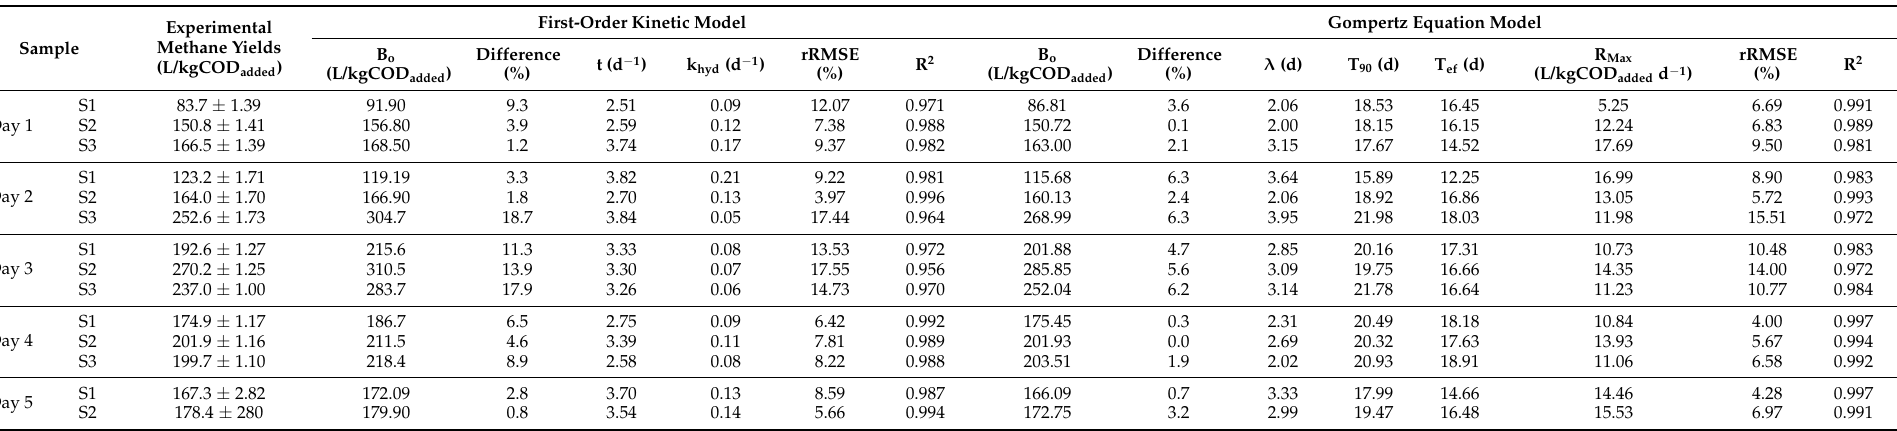
Table 3. Kinetic parameters during the anaerobic digestion of rendering wastewater in batch experiment at 37 ◦